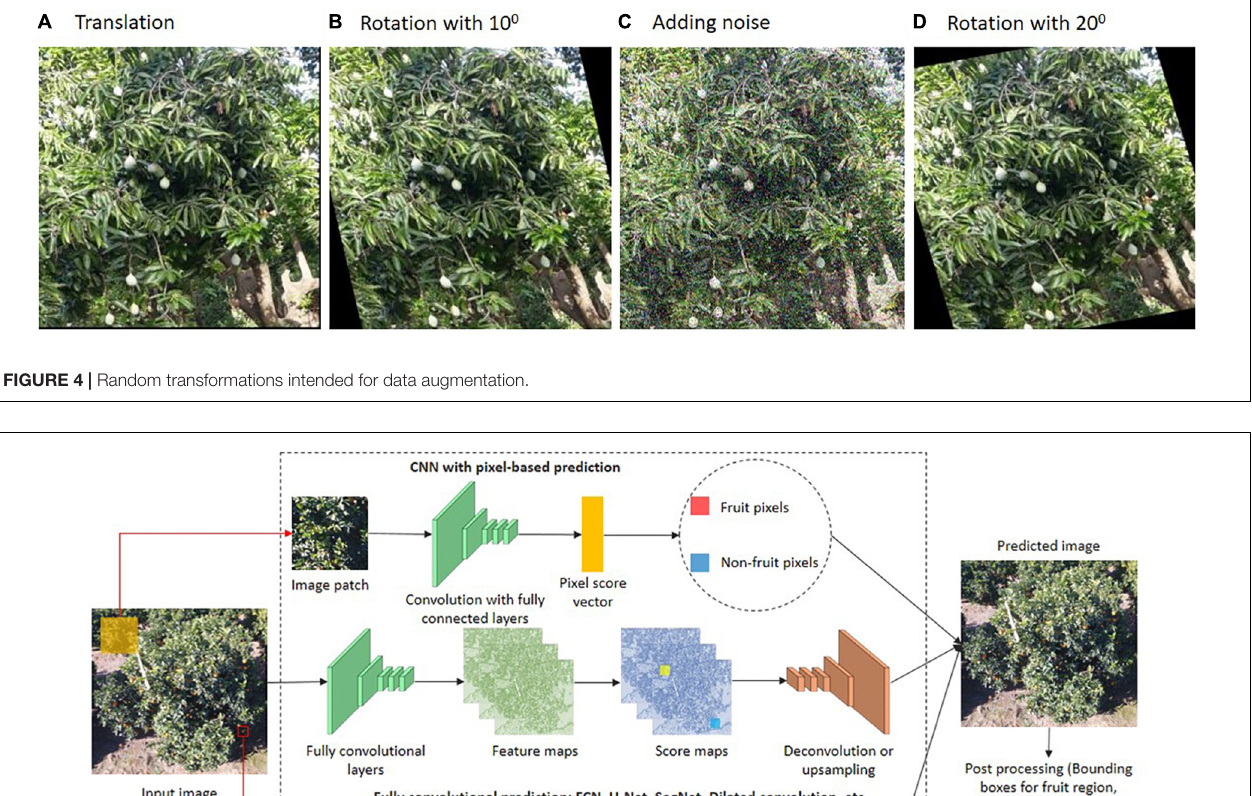
regions are the input for the architectures. Based on the score vector, each region is labeled as a fruit or non-fruit